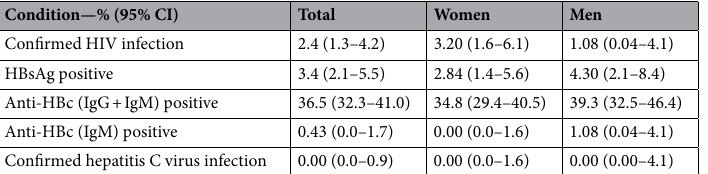
Table 3. Prevalence of HIV, hepatitis B and hepatitis C *. * Results were available for 466 subjects for HIV and 468 for all other